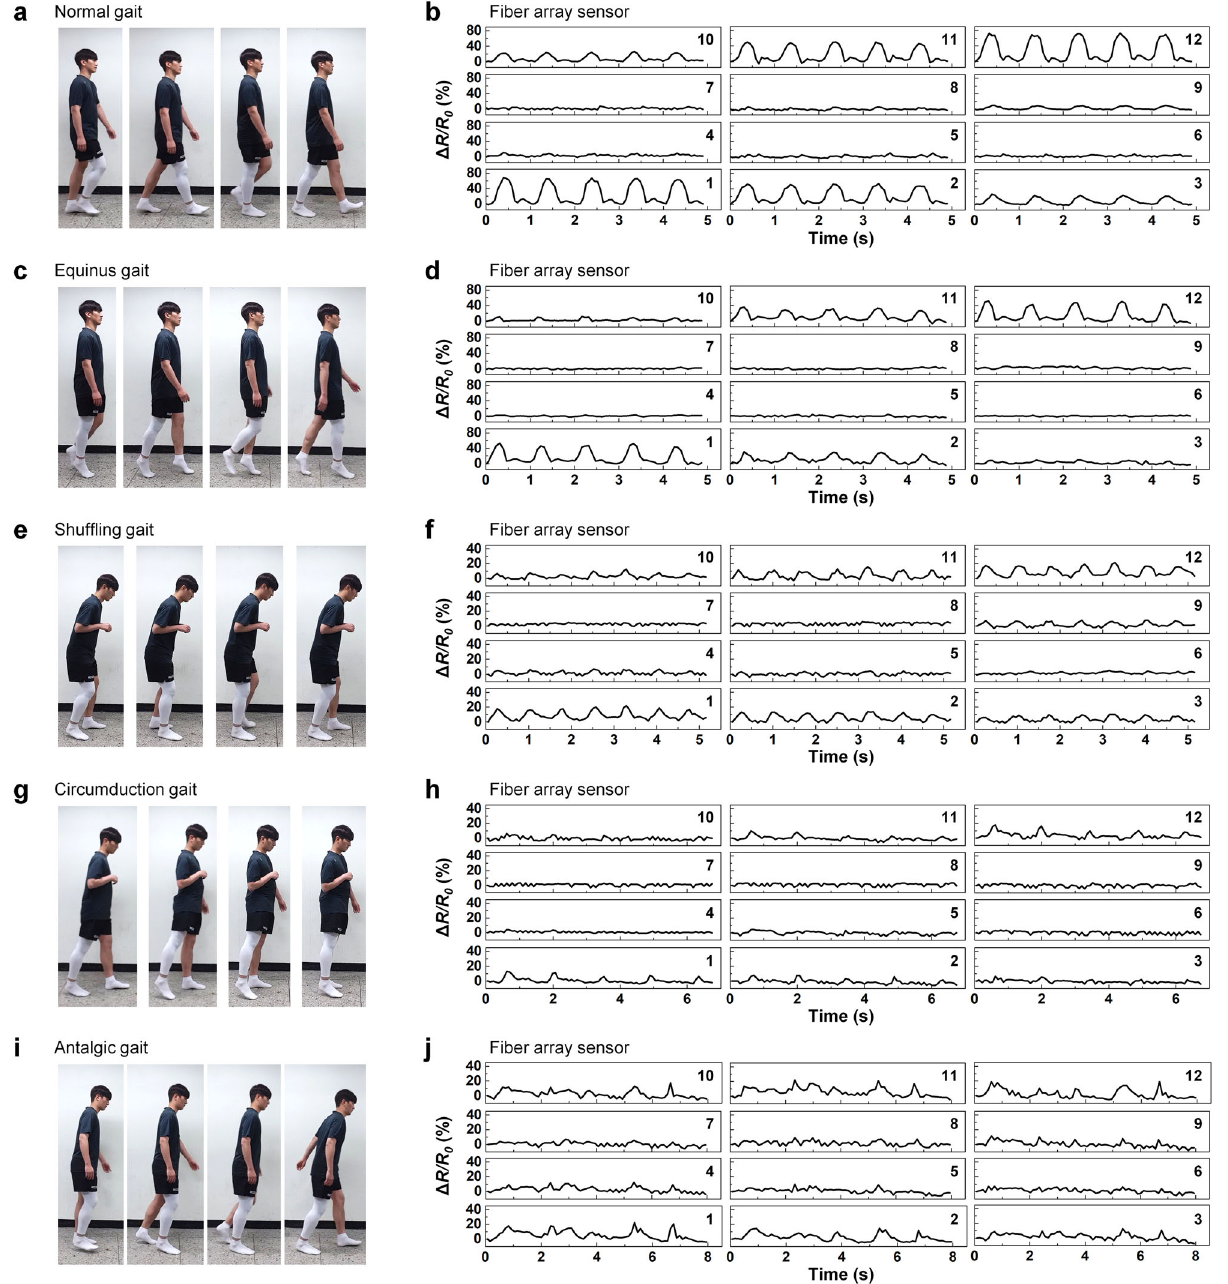
Fig. 6 Real-time monitoring of right knee motion in various gaits. Knee positions during the evaluation are indicated in panels ( a ), ( c ), ( e ), ( g ), and ( i ). Electrical characteristics (change in resistance) obtained using the fi ber arrayed fabric sensor during b normal, d equinus, f shuf fl ing, h circumduction, and j antalgic gait. I, M. Son, consent to the use of my picture in connection with the